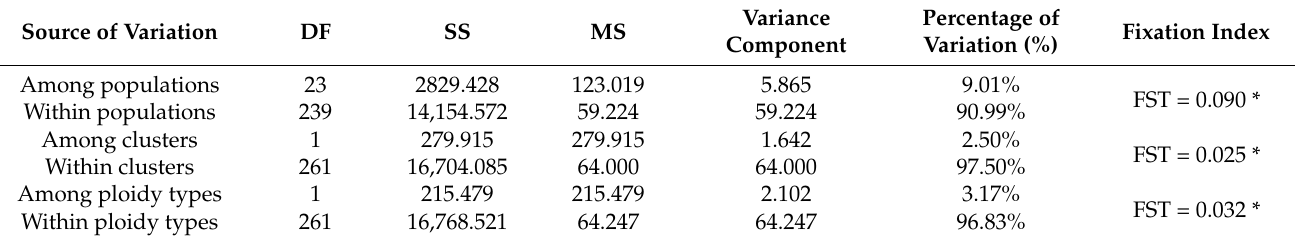
Table 2. Analysis of molecular variance (AMOVA) for A. chinensis populations.